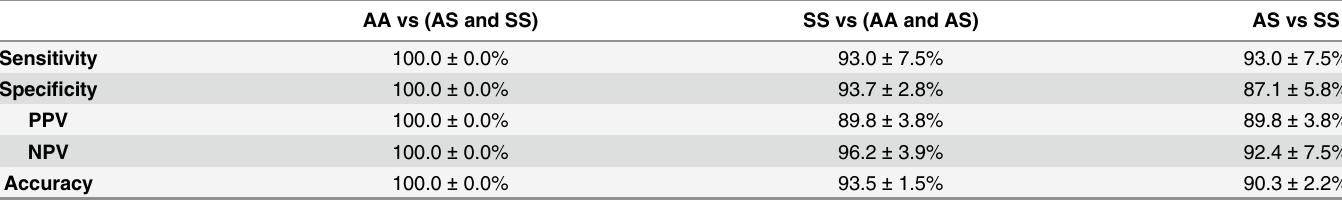
Summary of performance metrics for visual diagnoses made by different scorers (n = 5) on blood samples obtained from healthy subjects and SCD patients in New Orleans, LA. Mean values ±